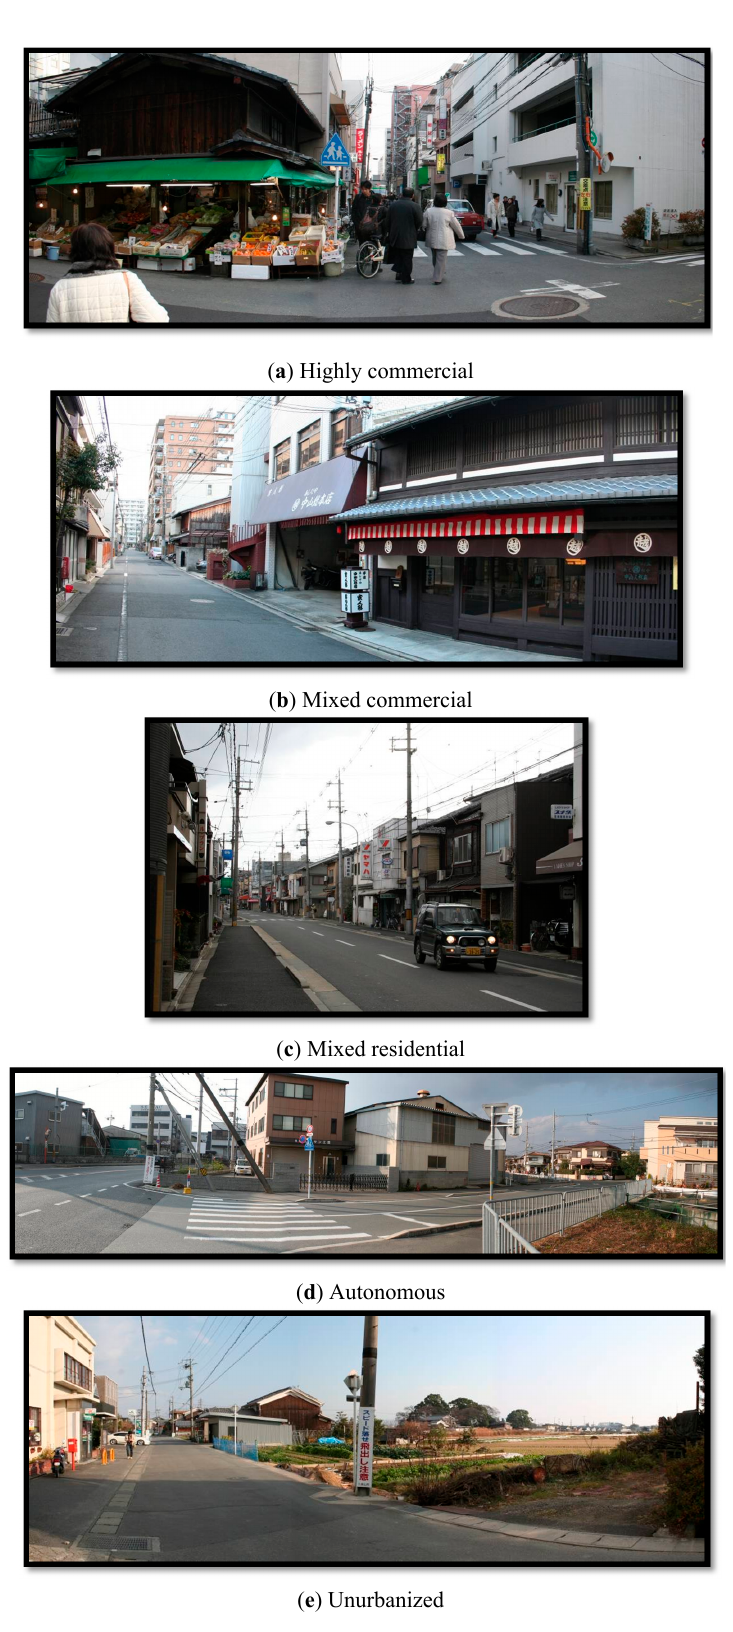
Figure 2. Representative images of the built environments in this study [67].